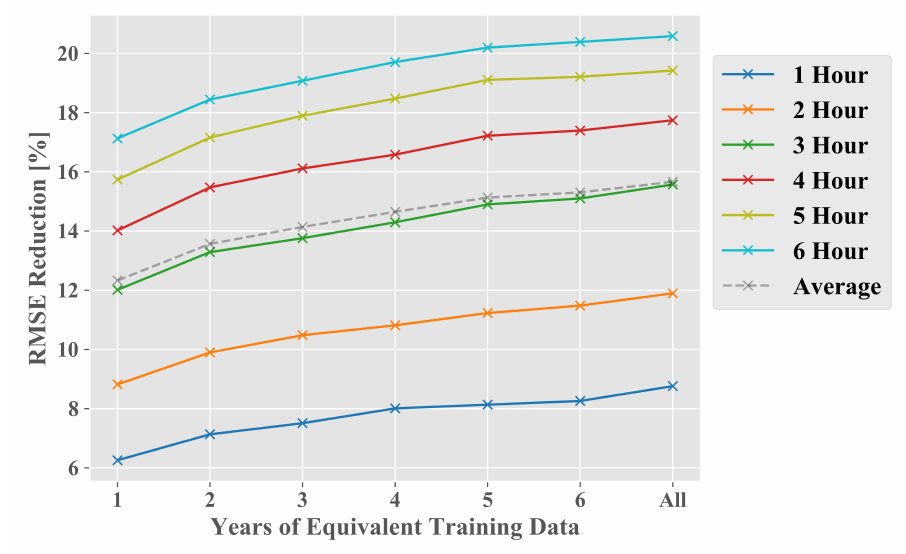
Figure 9. Similar to Figure 6 except data are taken from the SGP C1